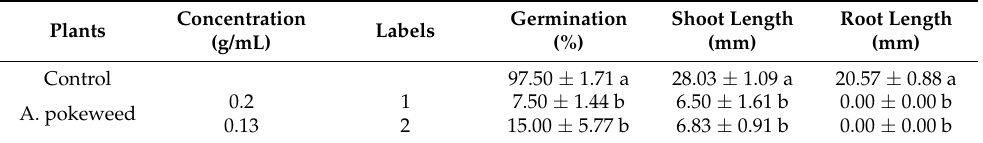
Different letters in the columns indicate statistically significant differences of measured parameters between treatments ( p ≤